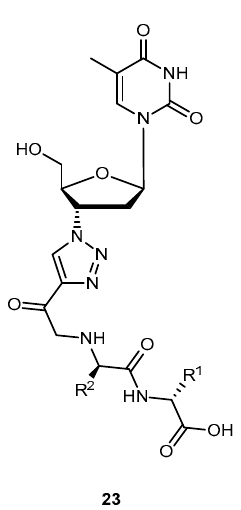
Figure 11. The general structure of dipeptide conjugates of 19 designed by Zhang et al. [60].